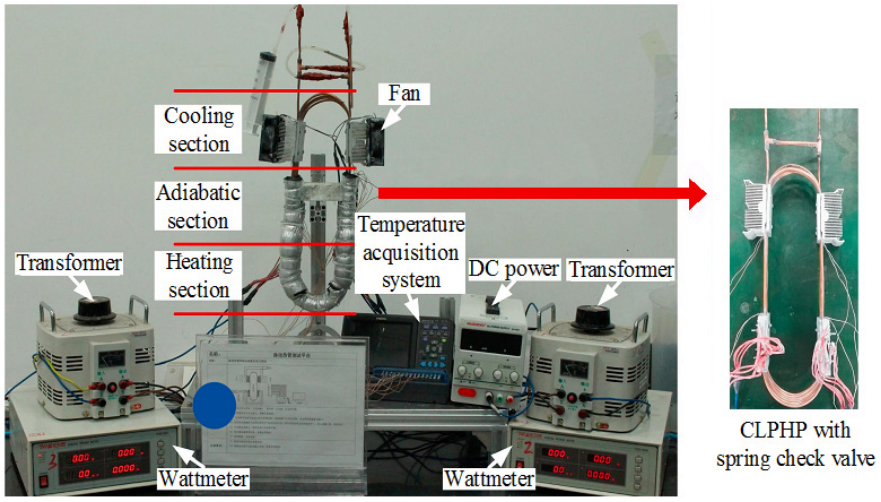
Figure 14. PHP with a spring-loaded check valve [136]. Feng et al. (2018).